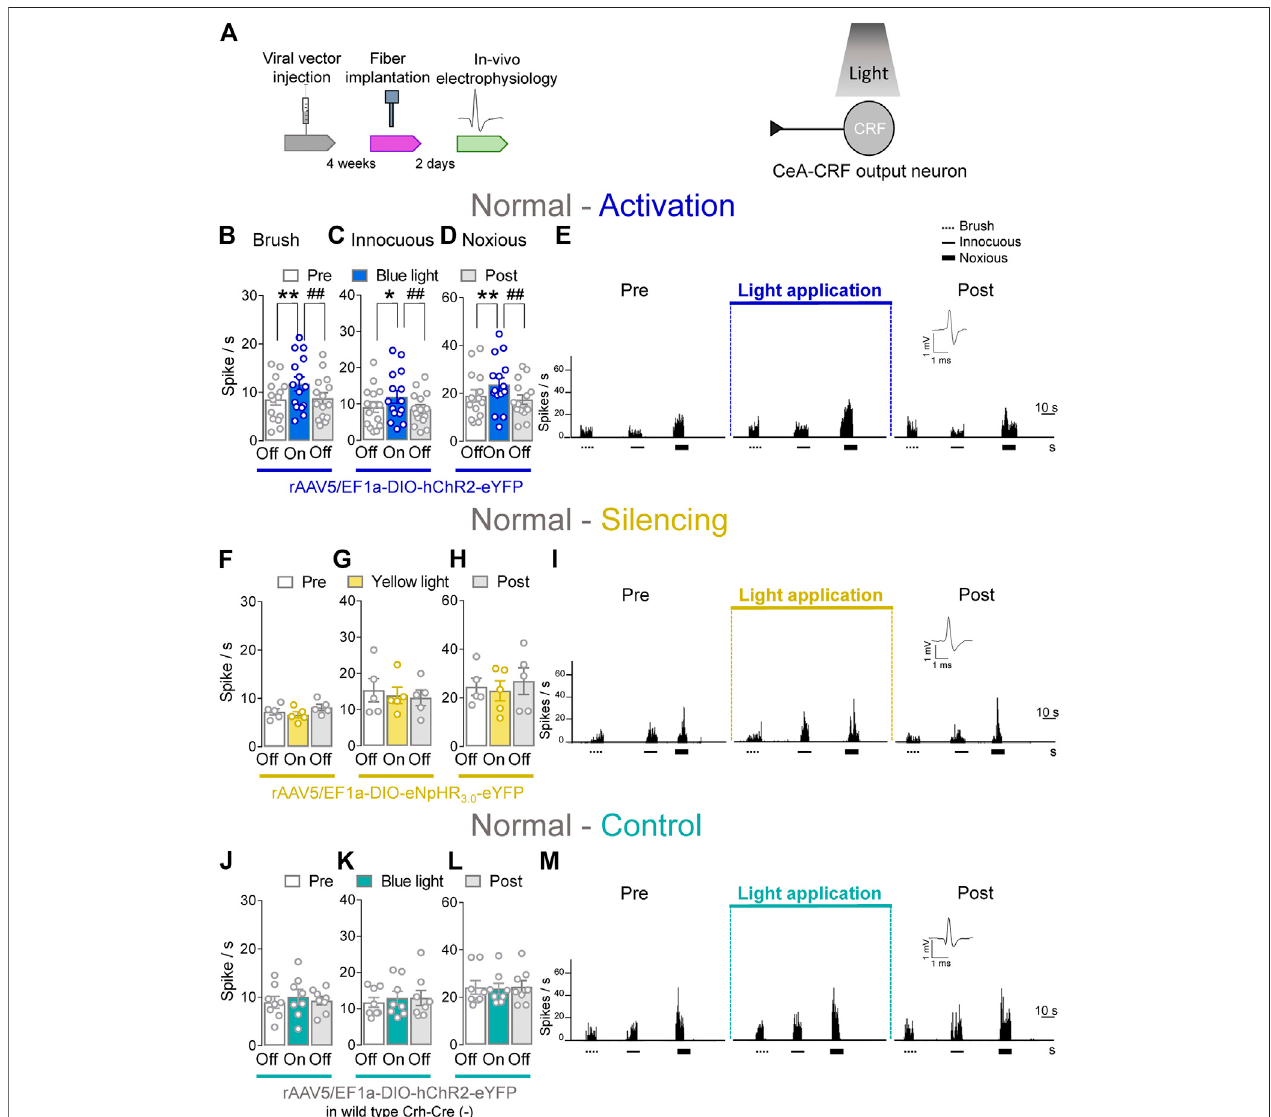
FIGURE 4 | Optogenetic activation of CeA-CRF neurons under normal conditions increases evoked activity of spinal cord neurons. (A) Experimental design. ResponsesofWDRneurons( n (cid:1) 15)tobrushingtheskin (B) andinnocuous (C) andnoxious (D) compression oftheleftkneejointweresigni fi cantlyenhancedbyoptical activation of ChR2 expressing CeA – CRF neurons with blue (473 nm) light ( “ On ” , 20 Hz, 5 mW, 5 – 10 min) compared to no light ( “ Off ” ) values in normal naive rats. (E) Peristimulus time histograms (500 ms bin size) show recordings of an individual WDR neuron recorded before, during and after blue (473 nm) light application (20 Hz, 5 mW, 5 – 10 min) in a normal naïve rat. Bar histograms show means ± SEM. *, p < 0.05, **, ## p < 0.01, repeated measures one – way ANOVA with Bonferroni posthoc tests. (F – H) Same display as (B – D) but for silencing of eNpHR 3.0 expressing CeA – CRF neurons with yellow (590 nm) light ( “ On ” ) exposure ( n (cid:1) 5). (I) Same display as (E) but for CeA – CRF neuron silencing. (J – L) Same display as (B – D) but in wild type control rats with blue (473 nm) light ( “ On ” ) application ( n (cid:1) 8). (M) Same display as (E) but in a wild type control